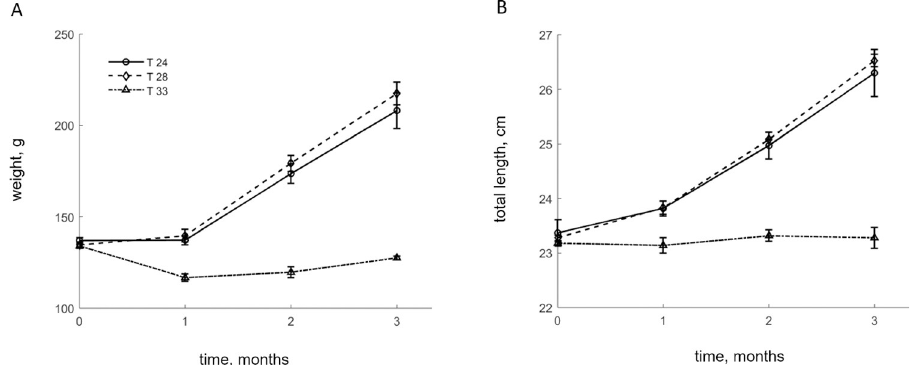
Fig 1. Weight (A) and total length (B) for E. sea bass reared under three temperatures (T-24, T-28, T-33). Points denote mean values between replicates and bars the standard deviation.